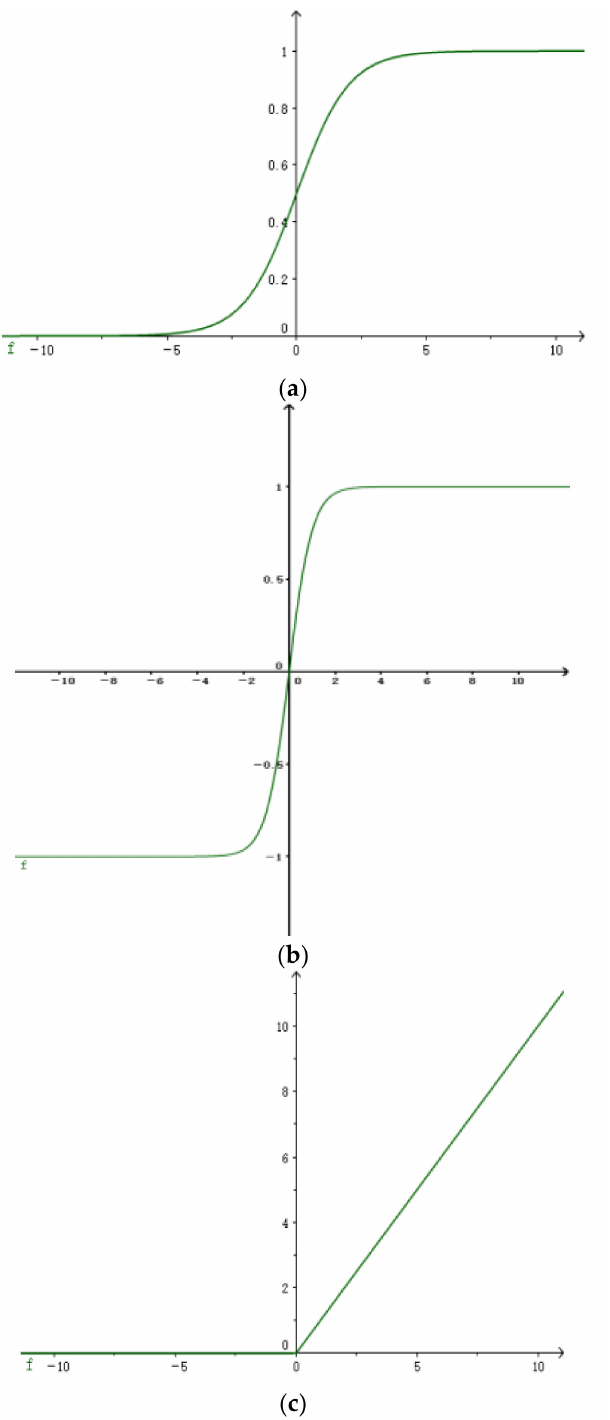
Figure 7. Geometric diagram of typical activation functions. ( a ) Sigmoid function. ( b ) Tanh function. ( c ) ReLU